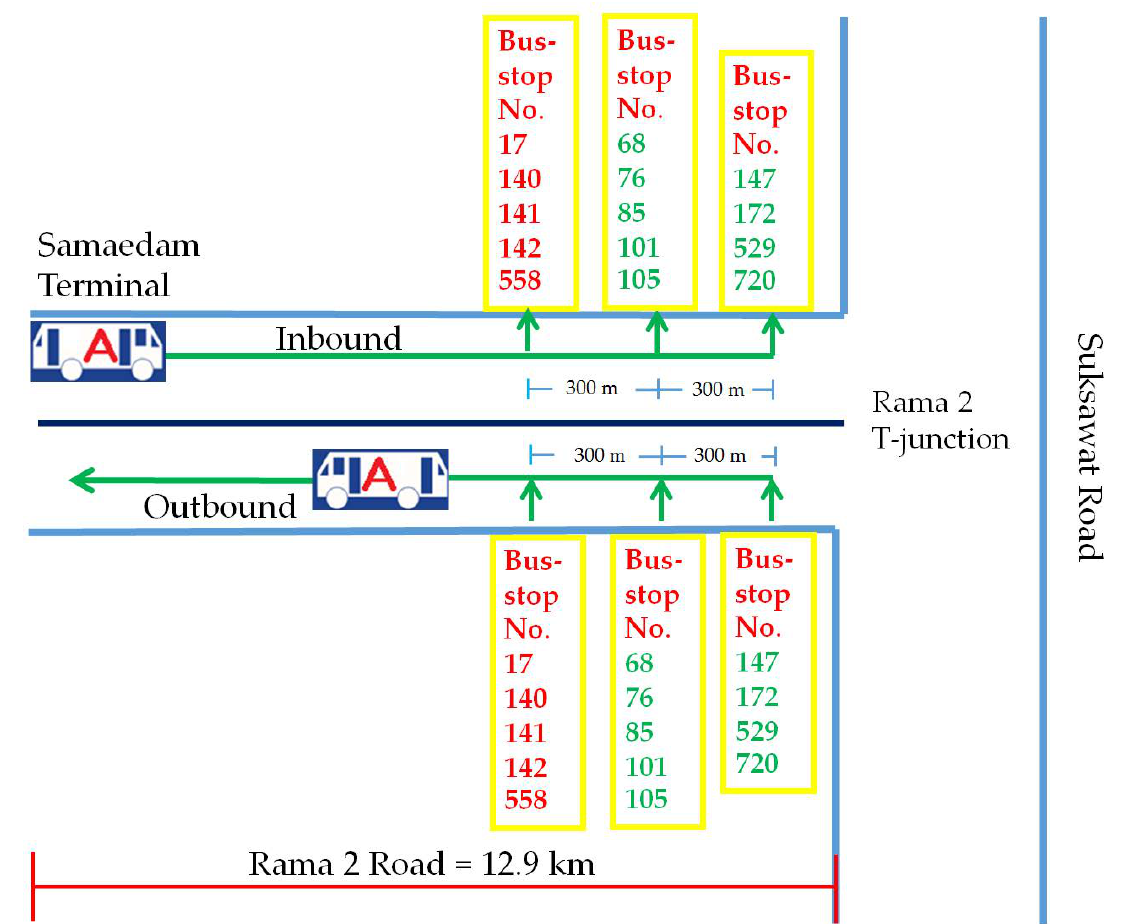
Figure 10. The Proposed Bus Reform with the Multiple Transfer Points at Rama 2